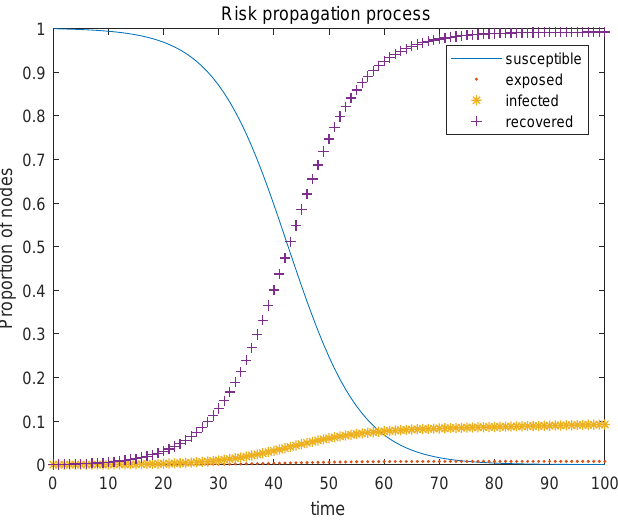
Figure 7. Risk propagation process in IEEE 30 bus